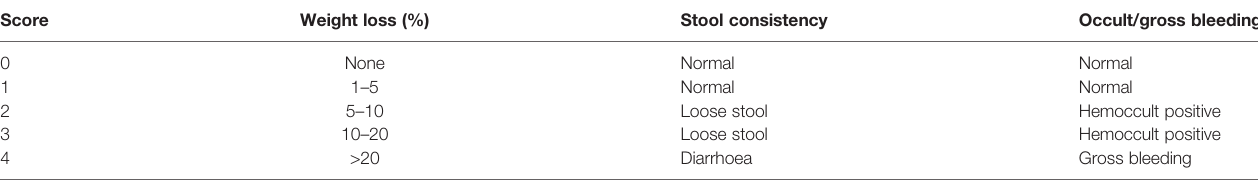
TABLE 2 | Disease activity index (DAI) scoring